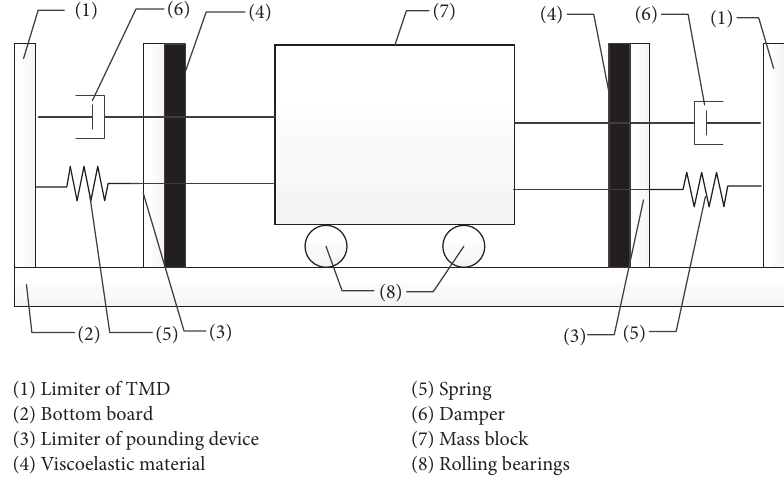
Figure 1: Schematic graph of PTMD with viscoelastic material layers.